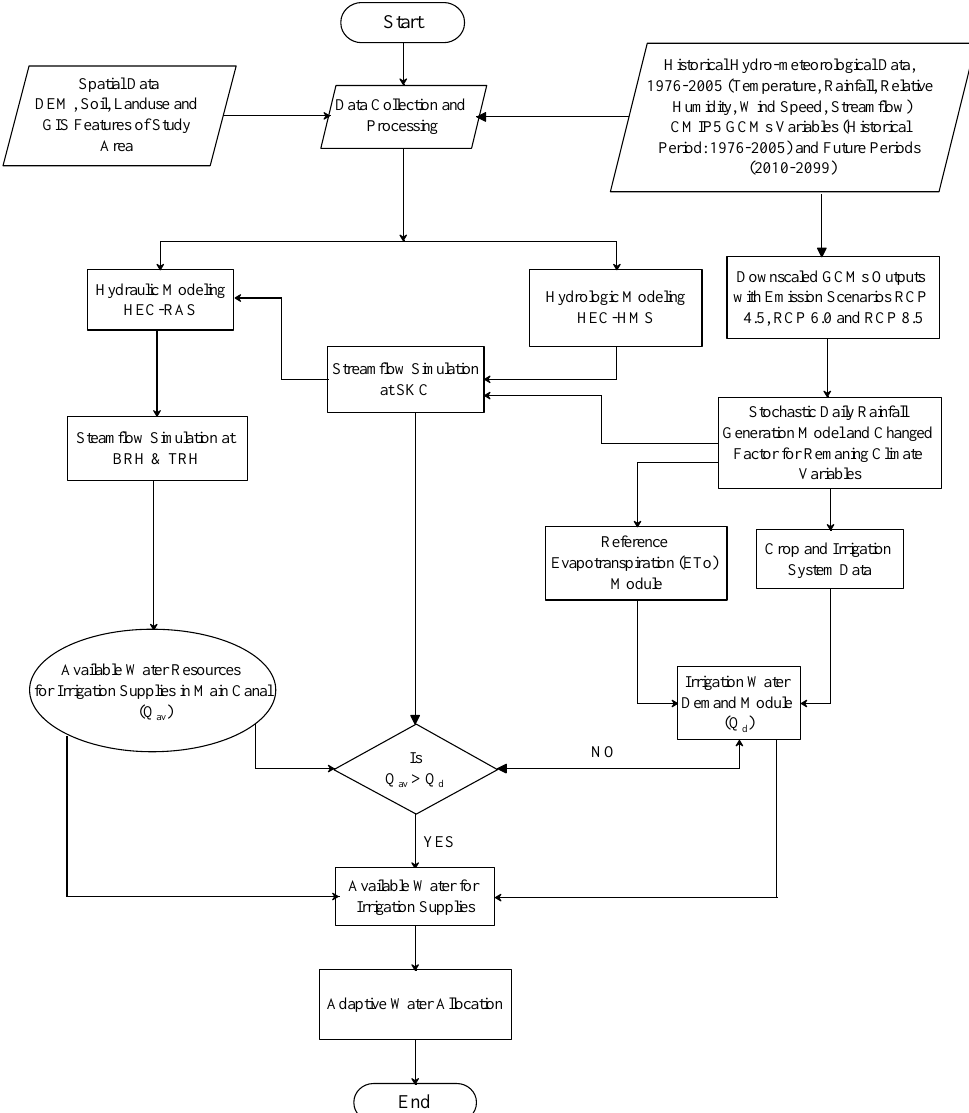
Figure 2. Framework for the adaptive water allocation under climate